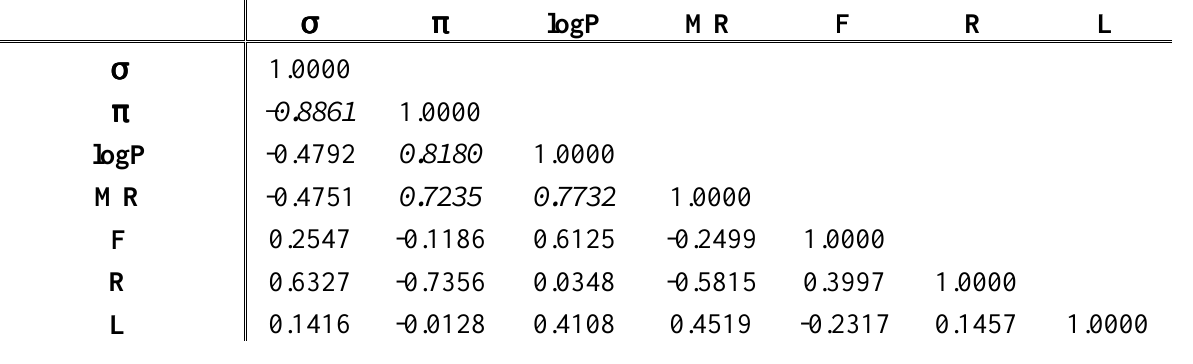
Table 4. Correlation matrix for the chosen electronic, steric and hydrophobic parameters.